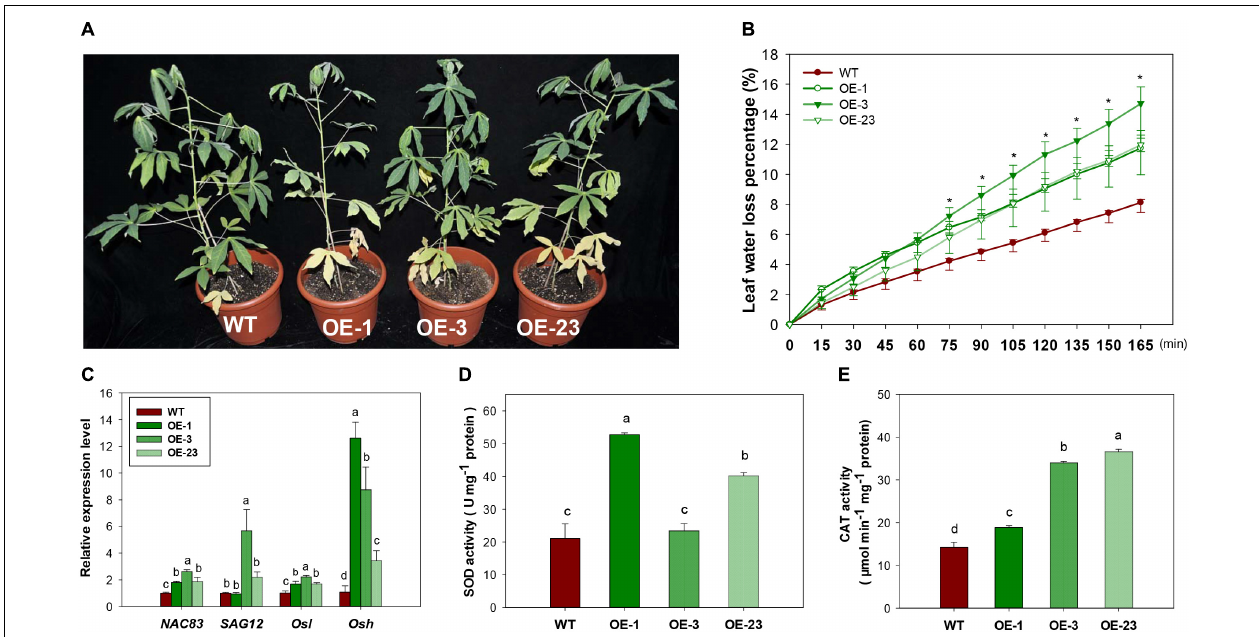
FIGURE 9 | Leaf senescence phenotype, physiological changes and gene expression in the wild-type (WT) and MeCWINV3 -overexpressed (OE) cassava plants. (A) Plant phenotype of early basal leaf senescence. (B) Transcript levels of senescence-related genes NAC83 (NAC domain-containing protein 83-like, XM_021768763.1), SAG12 (senescence-specific cysteine protease SAG12-like, XM_021749212.1), Osl (gamma-aminobutyrate transaminase 3, XM_021765427.1), and Osh (alanine–glyoxylate aminotransferase 2, XM_021768525.1). (C) Water loss capacity. (D,E) Total SOD and CAT activities in mature leaves. Different letters indicate significant differences (one-way ANOVA, p < 0.05).